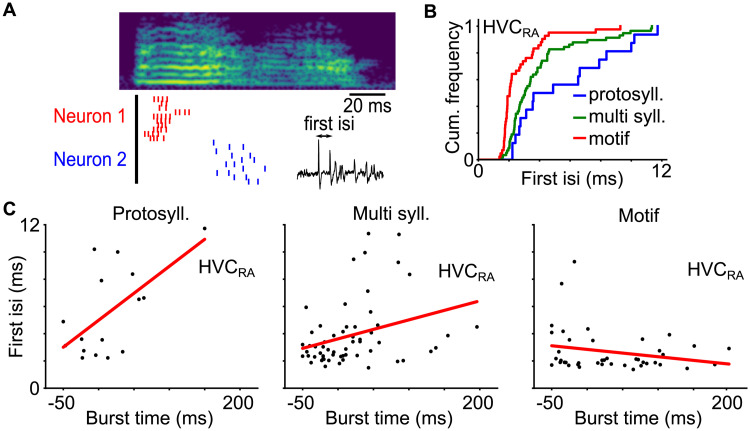
Burst tightness of HVCRA neurons as quantified with the first interspike interval at different stages of song development.A: Example of spike patterns of two HVCRA neurons in the protosyllable stage aligned to a syllable onset. B: Cumulative distributions of the first interspike intervals of HVCRA neurons. The first interspike intervals become progressively smaller on average as the song develops (multi-syllable versus protosyllable, p = 0.023, one-sided Wilcoxon rank sum test; motif versus multi-syllable, p < 0.0001, one-sided Wilcoxon rank sum test). C: The first interspike intervals of HVCRA neurons as a function of the burst times at the protosyllable, the multi-syllable and the motif stages. The red line is the linear least square fit. The slope is significantly positive for the protosyllable stage (p = 0.012, two-tailed t-test). The trend is weaker but significant for the multi-syllable stage (p = 0.017, two-tailed t-test), and is not significant for the motif stage (p = 0.14, two-tailed t-test).